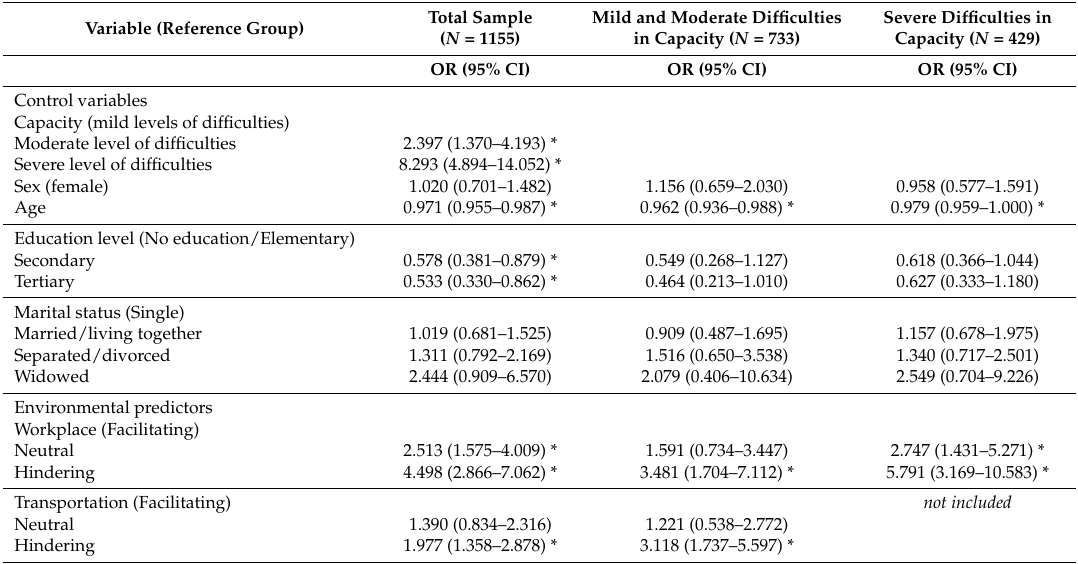
Table 2. Binary logistic regression models for the total sample ( N = 1155) and the strata by level of difficulties in capacity. Odds ratios (OR) and 95% confidence intervals (95% CI) predicting the risk of experiencing problems in work performance (WP) for workers with anxiety or depression are reported. Variables that did not remain in the regression models, because they were not statistically significant, are identified as “not